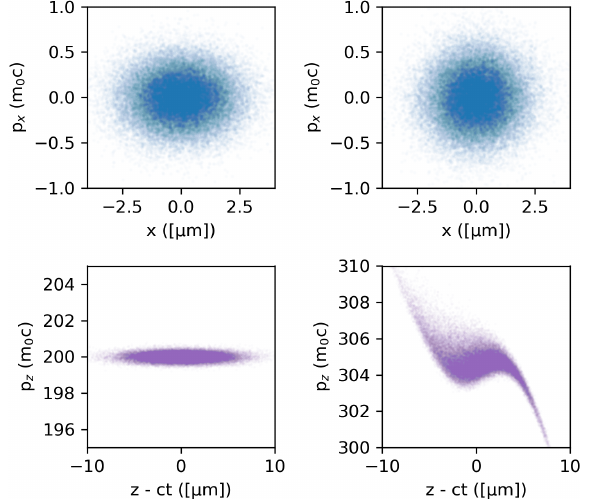
FIG. 2. Witness phase space before acceleration (left) and after acceleration (right). The transverse phase space (blue) does not present any major deformation. The longitudinal phase space (purple) shows that the spread increase occurs mostly in the tails while the moment distribution in the beam core is flat.